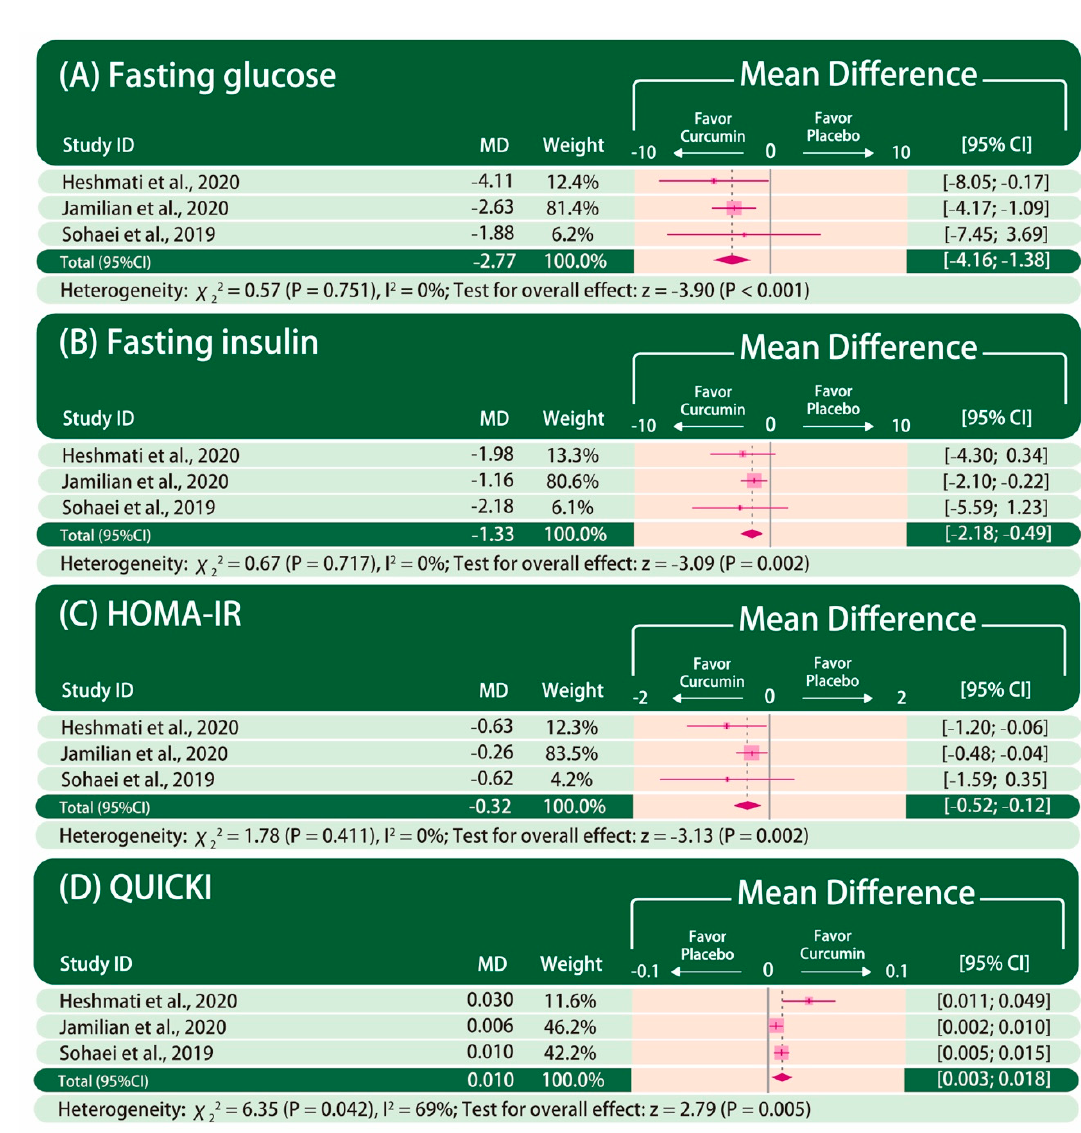
Figure 2. Forest plot of glycemic control. The mean difference between curcumin and placebo is calculated as the value in the curcumin group subtracted by that in the placebo group (curcumin–placebo). CI: confidence interval. MD: mean difference.